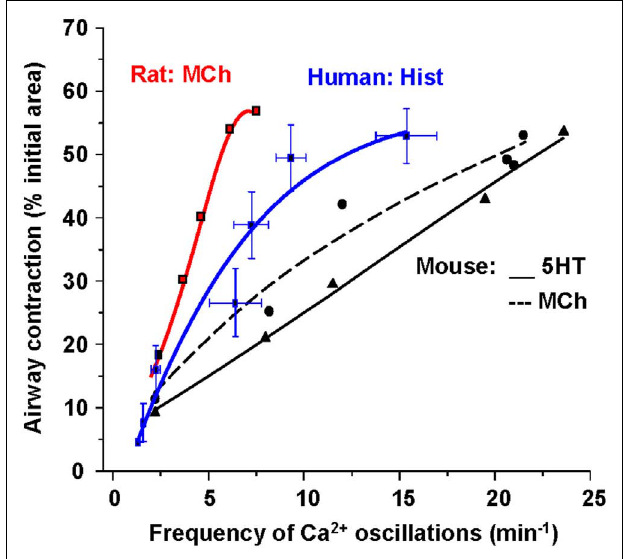
FIGURE 6 |The relationship between Ca 2 + oscillation frequency of ASMCs and the extent of airway contraction. The gradient of the relationship is different for each